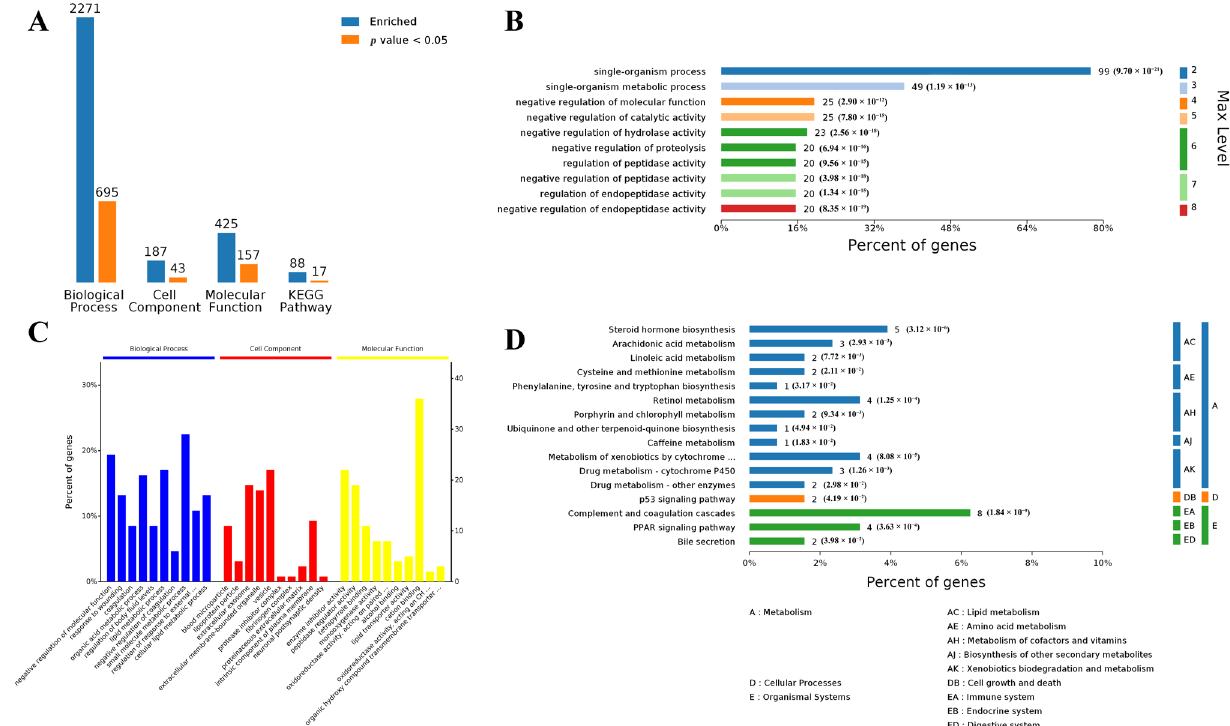
Figure 3. Bioinformatic analysis of DEGs in adipose tissue using four analysis categories: BP, CC, MF, and KEGG pathways. ( A ) Counts for each category represent the total associated terms in the database with the query protein list. Terms with p value < 0.05 are statistically significant. ( B ) BP hierarchy of DEGs, the number of involved genes, and corresponding p value in a specific biological process are shown on the right side of the column. ( C ) The ten most significantly enriched terms in level 4 of gene ontology hierarchy, information of percentage, and a number of involved genes in a term are shown in the left and right y-axes. ( D ) KEGG hierarchy of DEGs, the number of involved genes, and corresponding p value in a specific biological process are shown on the right side of the column.